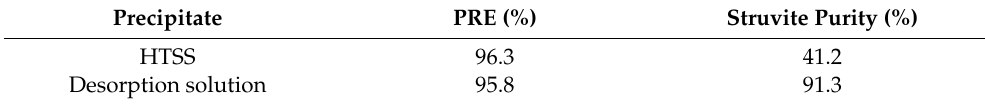
Figure 6. XRD pattern ( a ) and SEM images ( b ) of the precipitate. Table 5. PRE and struvite purity of precipitate obtained from the HTSS and desorption solution. Precipitate